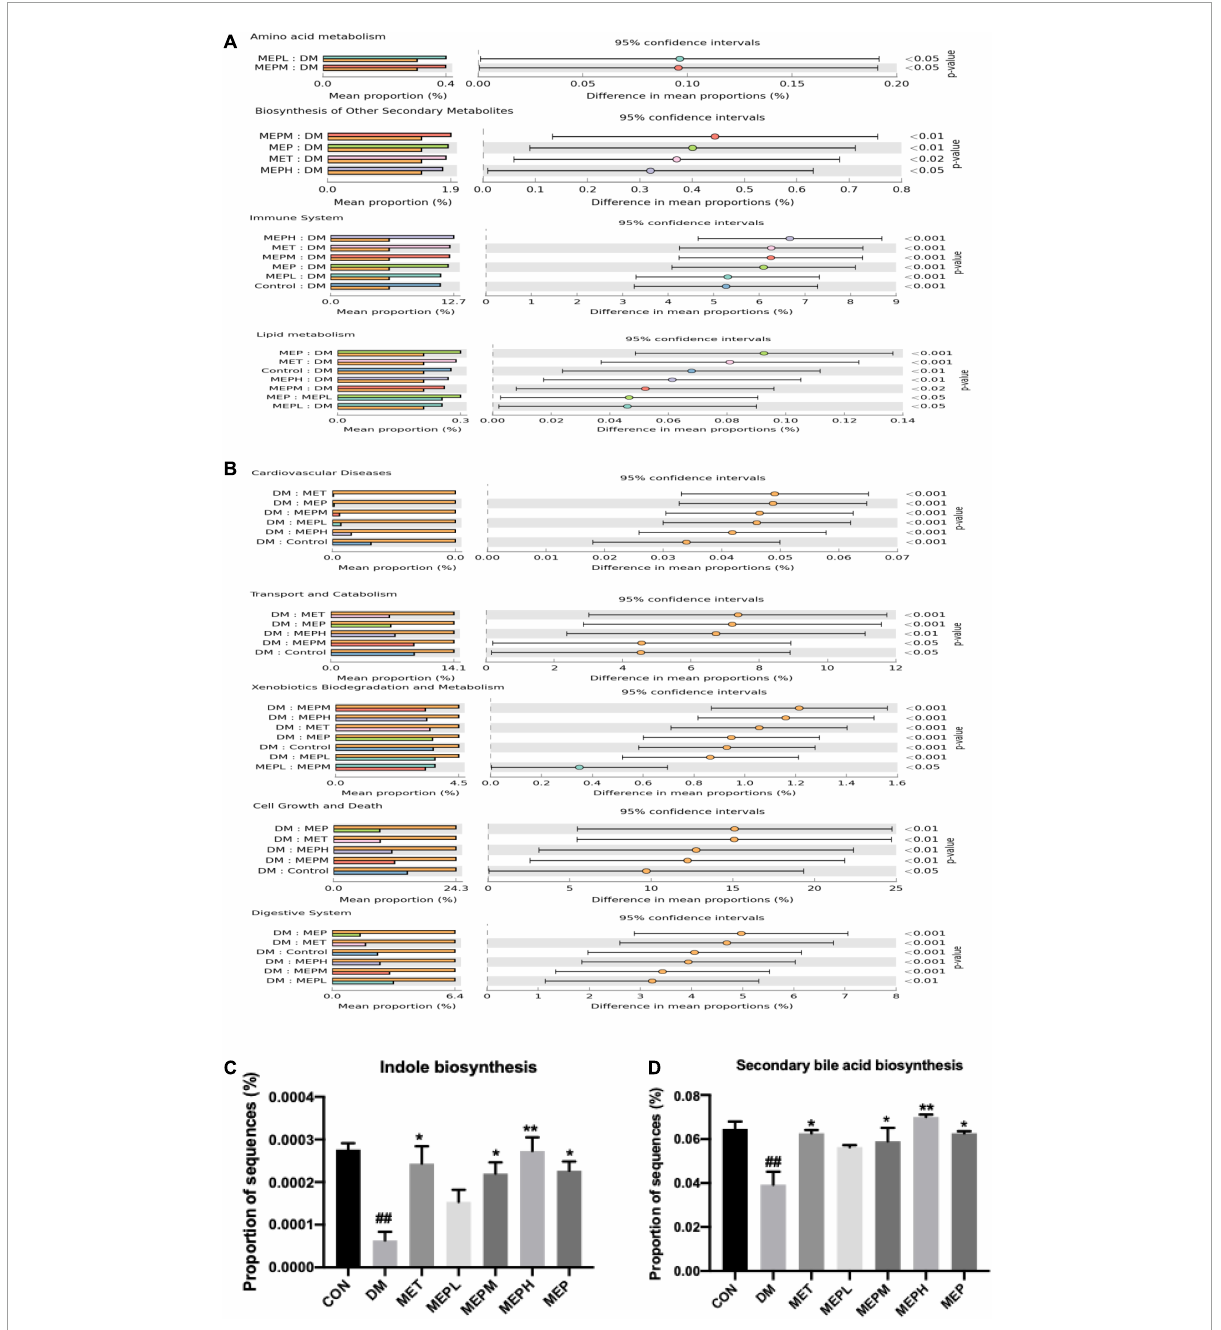
FIGURE6 Functional profile analysis of gut metabolites in T2DM mice. (A,B) COG (Clusters of Orthologous Groups) shows the metabolic pathways functional predictions and KEGG database level 3 indicated with their confidence interval ratio of differences, while p -value shows on the right side among different groups. (C) Expression of genes involved in indole biosynthesis and (D) Secondary bile acid biosynthesis. # indicates a significant difference compared with control (CON) group. ## p < 0.01 vs. Control. * indicates a significant difference compared with the DM group. * p < 0.05, ** p < 0.01 vs.